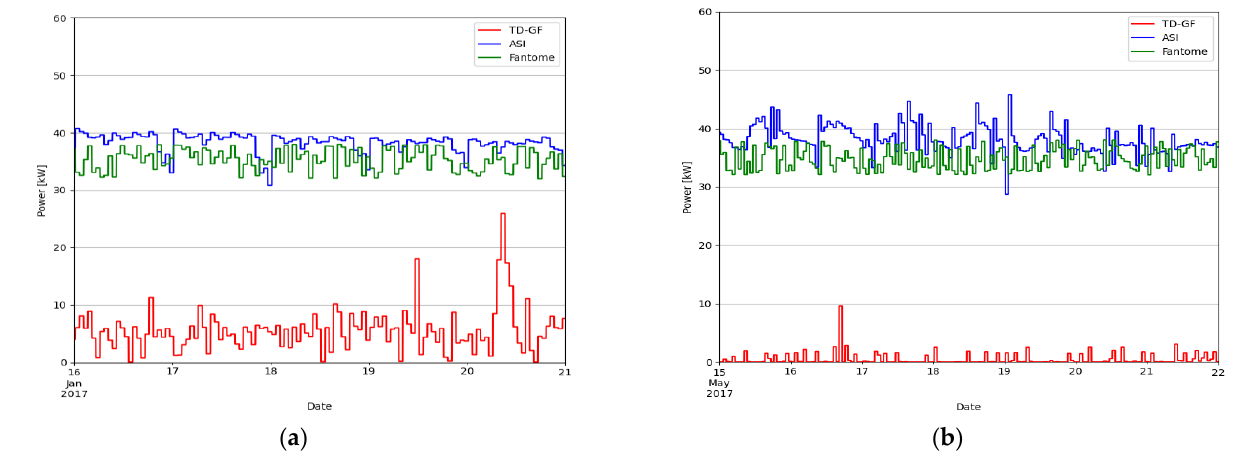
Figure 10. Power data for the TD-GF, ASI and Ghost loads, ( a ) Training Period, ( b ) Test Period.